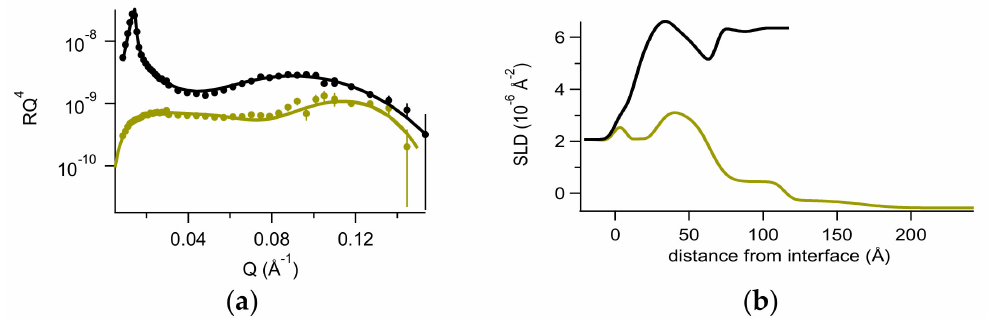
Figure 7. ( a ) Reflectivity curves (symbols), relative best fits (lines), and ( b ) obtained SLD profiles of the d 62 DPPC-GM1 + mucin model system after interaction with d , l -ARGO7 investigated in H 2 O NaCl (olive) and D 2 O NaCl